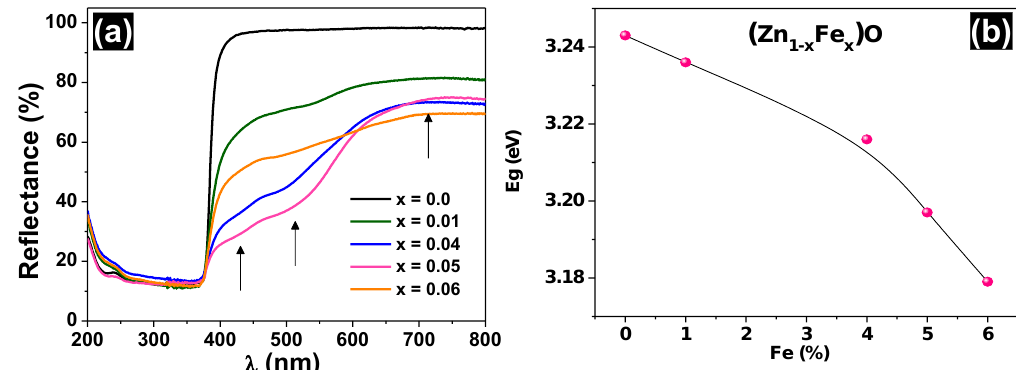
Figure 3. UV-Vis diffuse reflectance spectra ( a ) and bandgap variation as a function of iron concentration ( b ) for the undoped and Fe-doped ZnO.